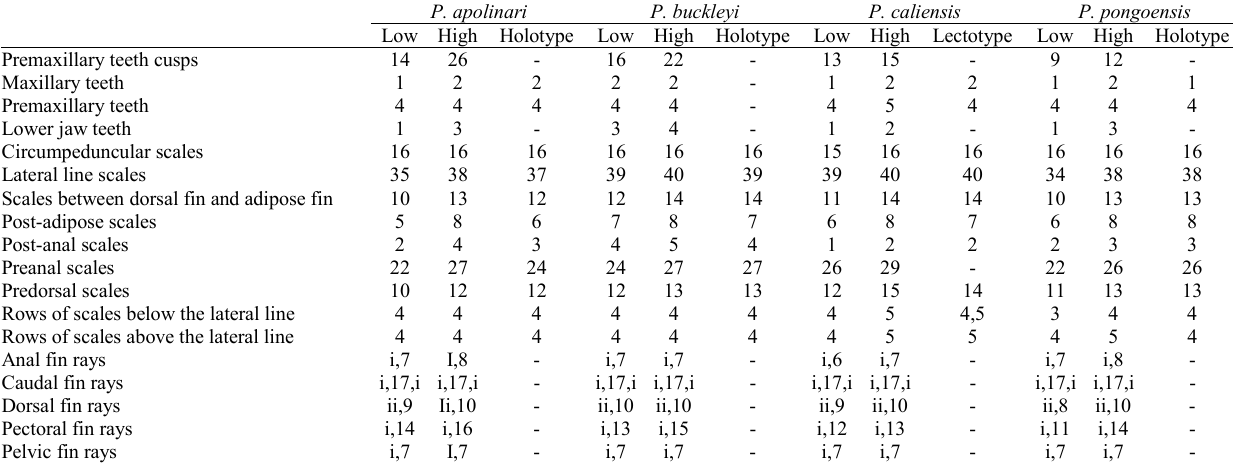
Table 4. Counts for Parodon apolinari (n = 108), P. buckleyi (n = 20), P. caliensis (n = 27), and P. pongoensis (n = 24). P.